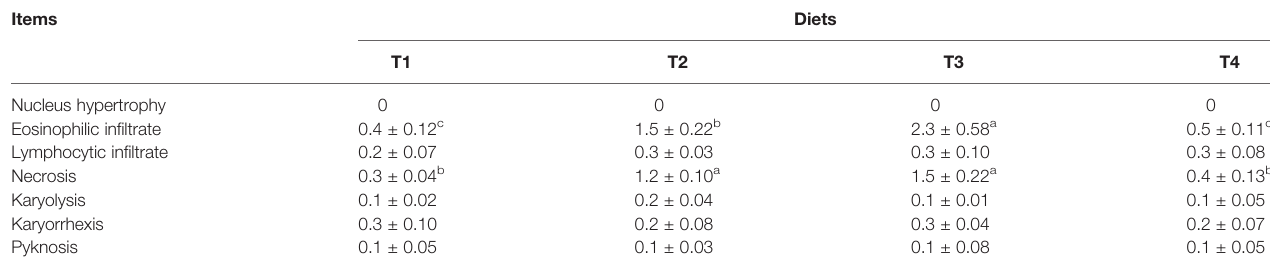
TABLE 4 | Liver histological indices of L. maculatus fed experimental diets. Items